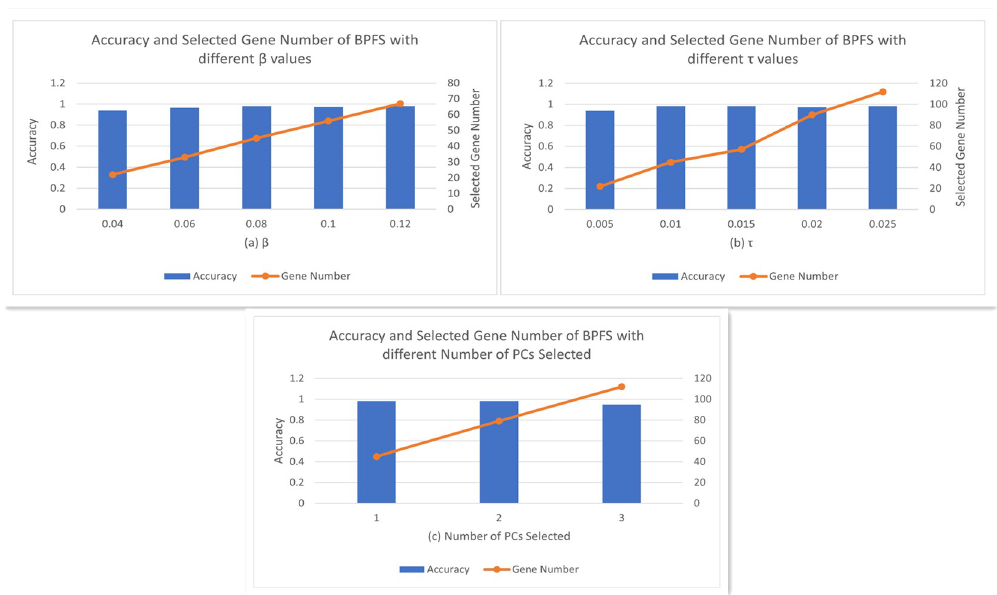
Fig 2. Accuracy vs different parameter values on THCA datasets.